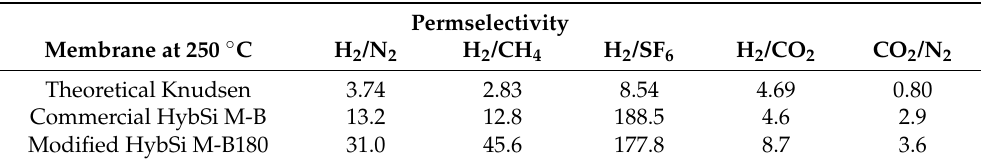
Table 2. Permselectivity values of the commercial HybSi ® membrane M-B and modified membrane M-B180 for various gas pairs. Theoretical Knudsen values are also